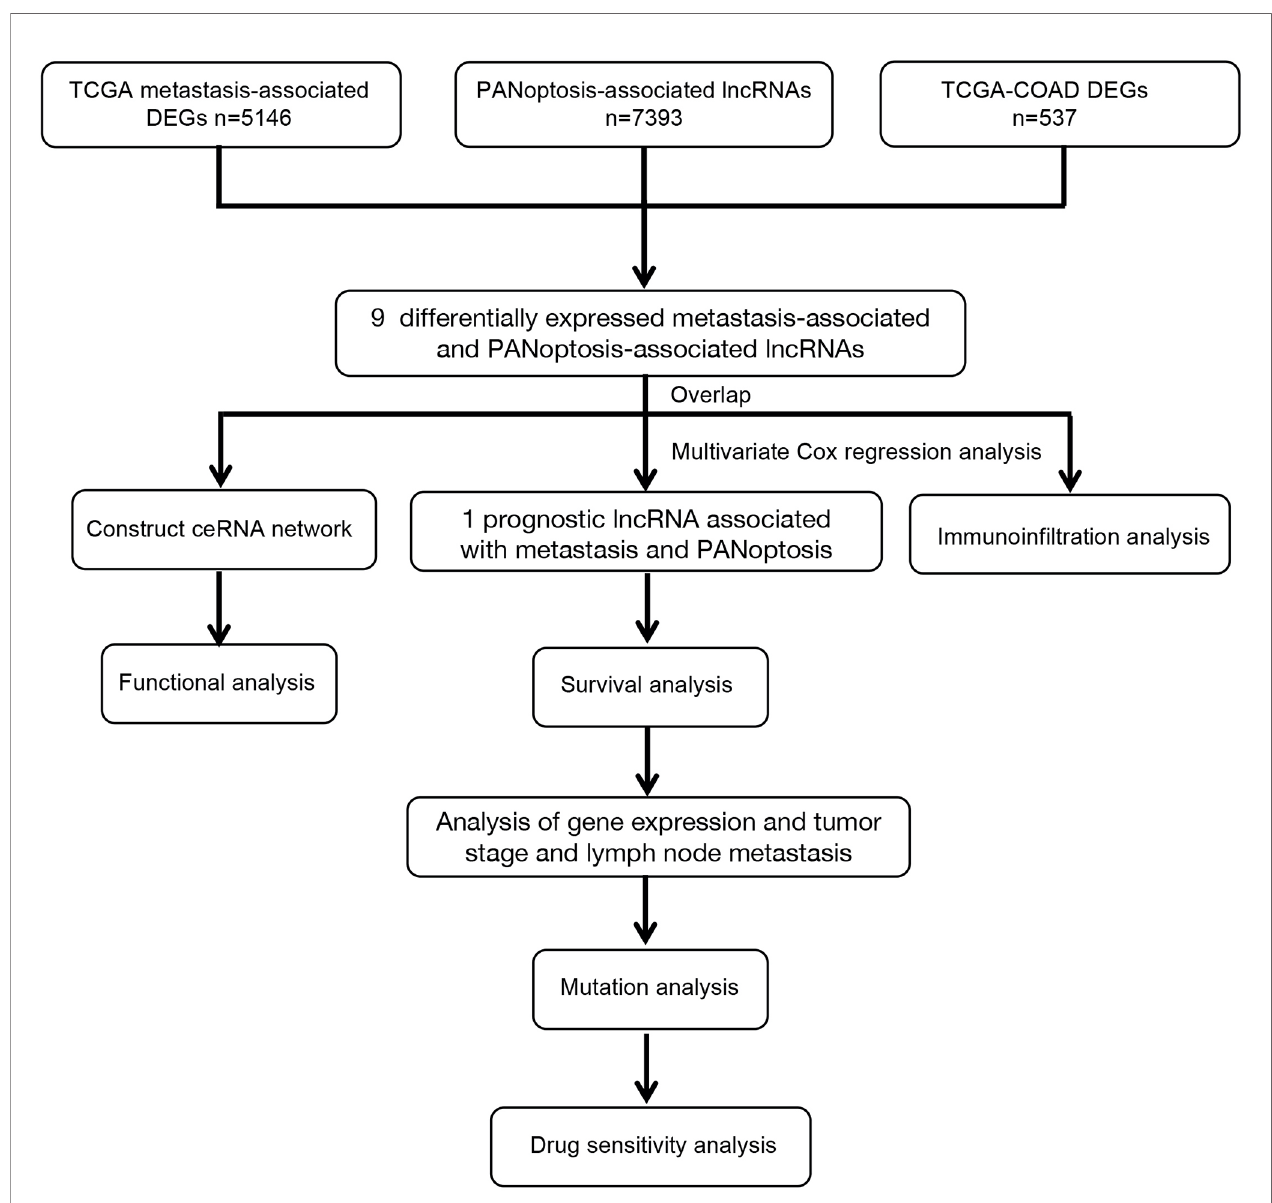
FIGURE 1 | Work fl ow